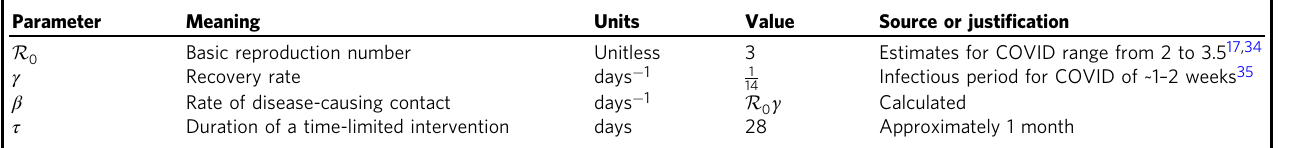
Table 1 Model parameters, default values, and sources/justi fi